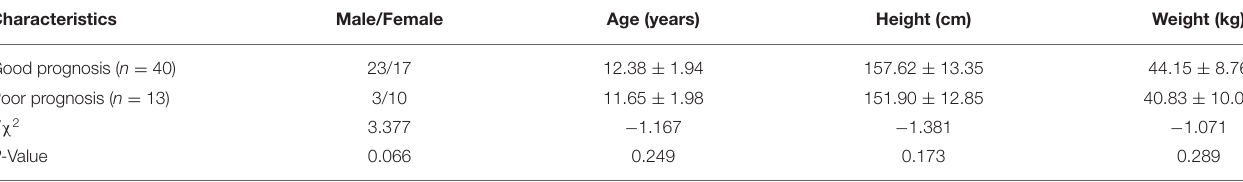
TABLE 2 | Comparison of general information for good prognosis group and poor prognosis group (Mean ± SD).